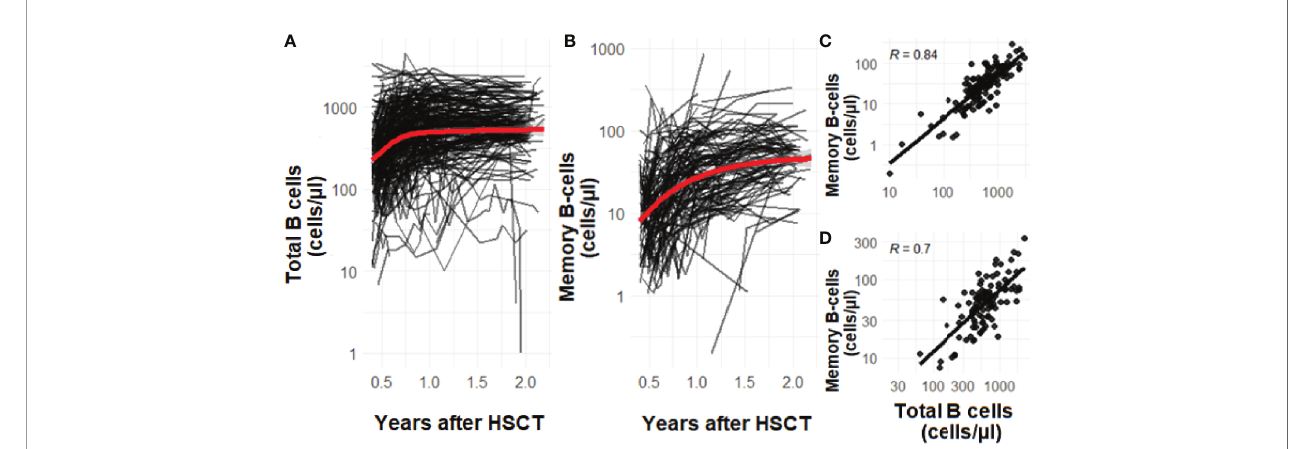
FIGURE 2 | (A – D) The effect of time on total (A) and memory B-cell (B) numbers after HSCT. The correlation of memory B-cells and total B-cells 1 year ( C , n=223) after HSCT and 2 years ( D , n=86) after HSCT. Data is presented as individual trajectories and dots in black and as the average reconstitution in red. R is the Pearson ’ s correlation coef fi